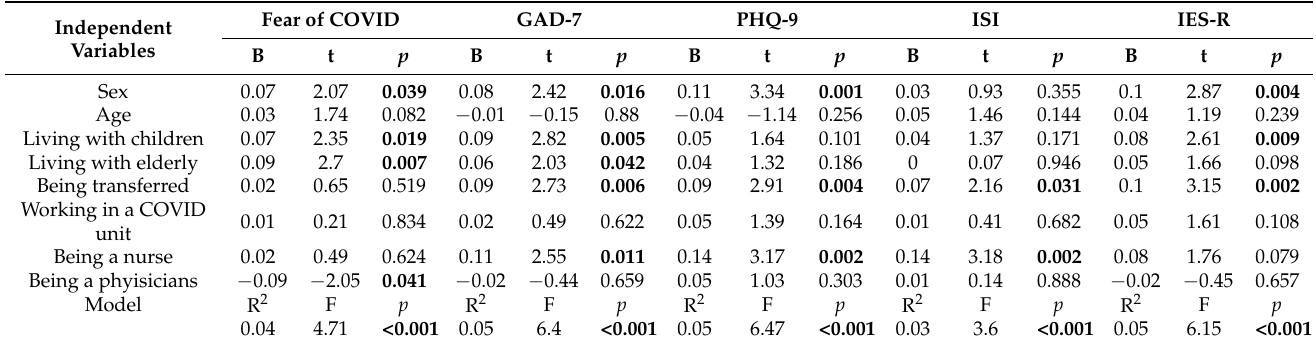
Table 6. Predictors of psychopathological